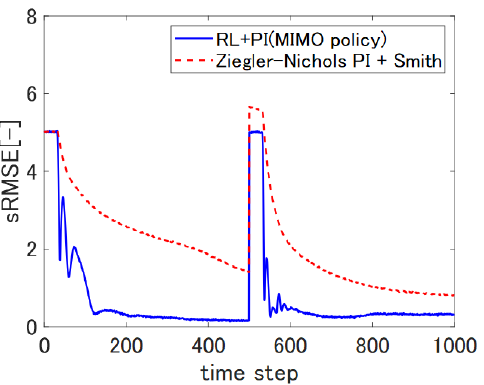
Figure 11. Changes in sRMSE metrics when the reference thickness is changed from 70 to 75 at the 500th sampling